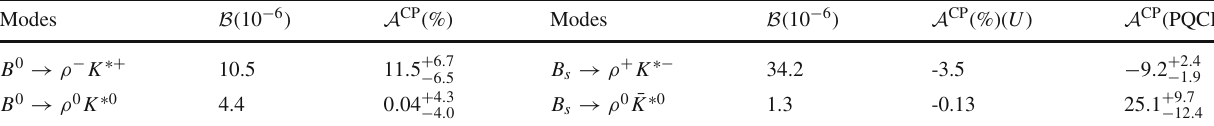
Table 8 The direct CP asymmetries (%) in B s → ρ K ∗ decays via U -spin relation together with the direct PQCD prediction Modes